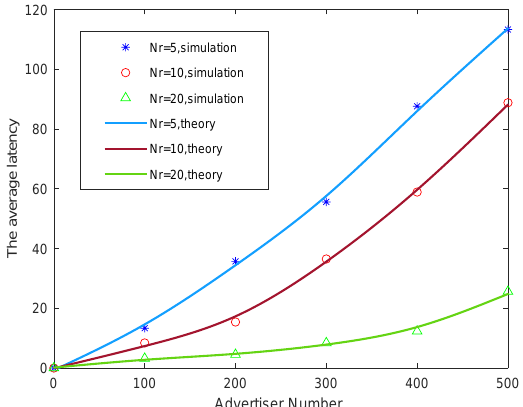
Figure 5. The average discovery latency respect to advertiser numbers.